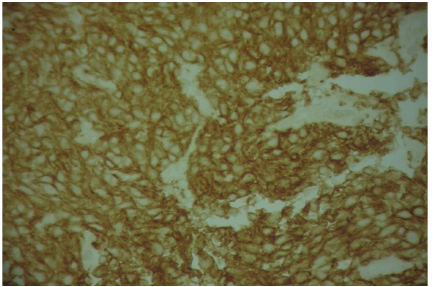
Figure 5: Positive immunostaining with c-Kit (CD117). Note di ff use membranous pattern (HE ×